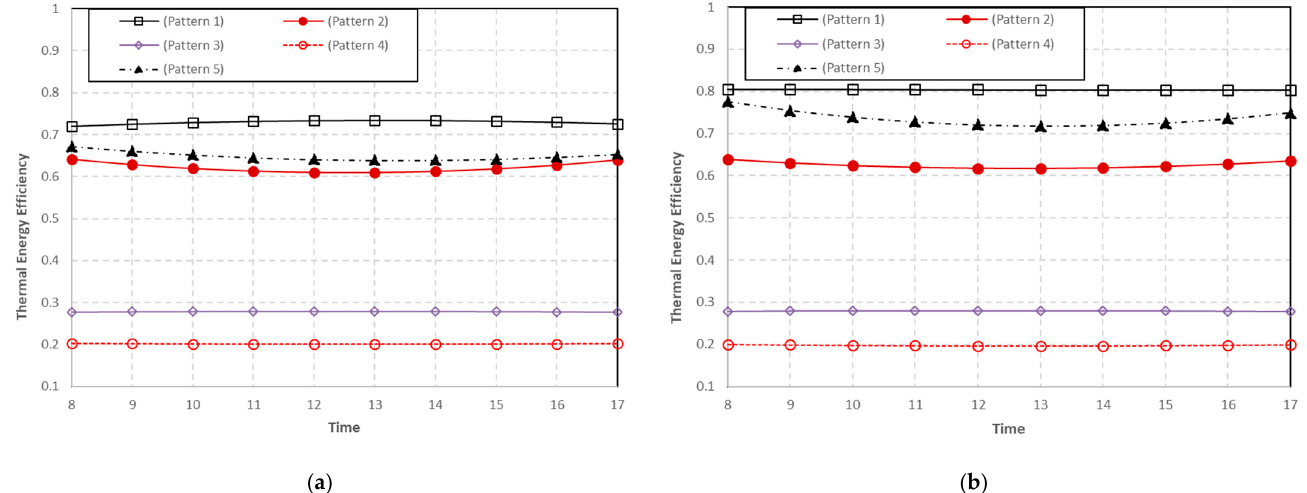
Figure 14. Hourly variations in e ffi ciency of thermal energy for di ff erent con fi gurations. ( a ) during Winter day ( b ) during Summer day.